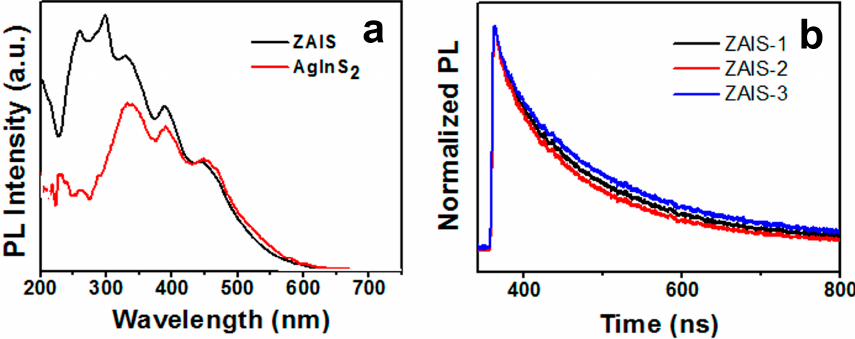
Figure 3. ( a ) PL excitation spectra and ( b ) PL decay curves of ZAIS-1, ZAIS-2, and ZAIS-3. Table 3. Decay times and amplitude constant ratios of ZAIS-1, ZAIS-2, and ZAIS-3.